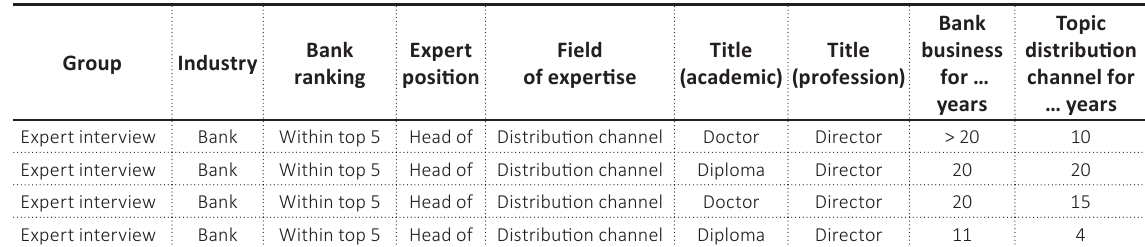
Table 3. Characteristics of the